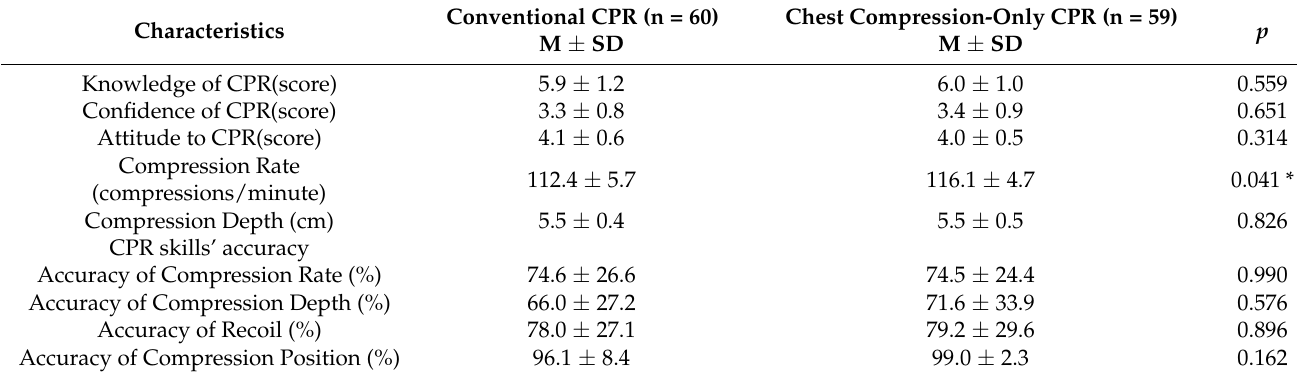
Table 2. Knowledge, confidence, attitude, and CPR skills right after CPR